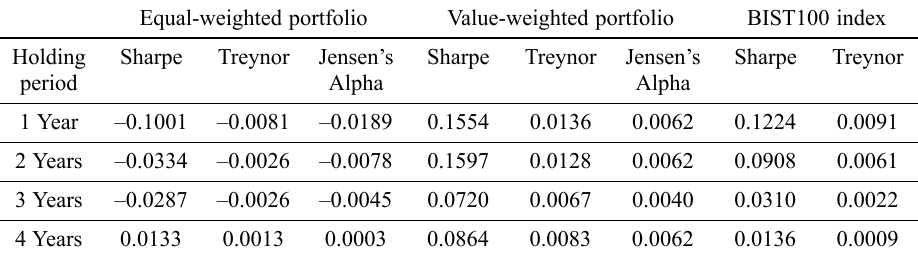
Table 7. Long run risk-adjusted performance of newly listed firms’ portfolios Equal-weighted portfolio Value-weighted portfolio BIST100 index